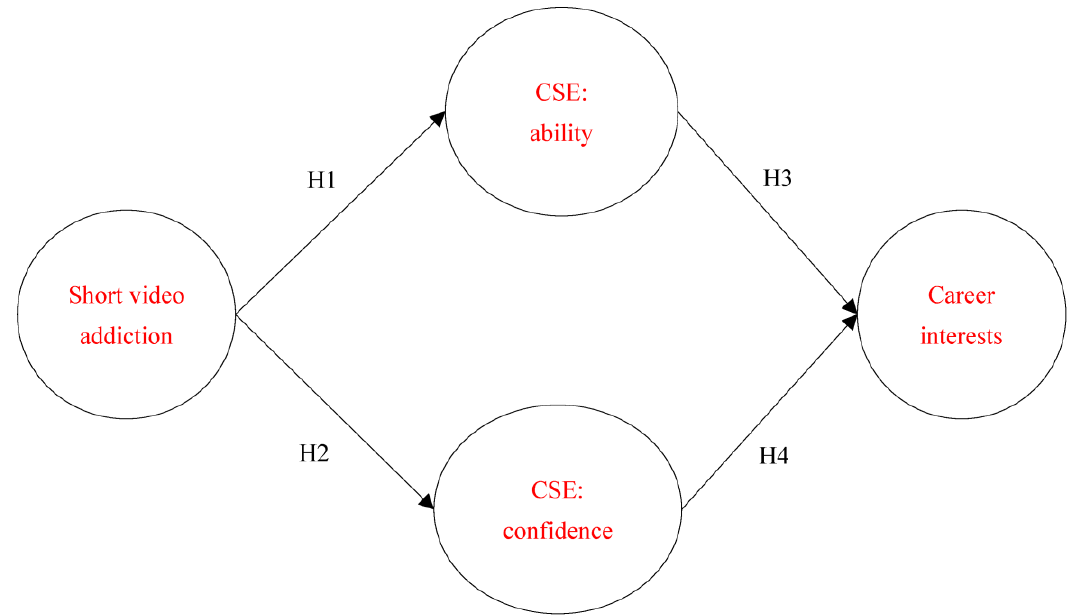
Figure 1. Research